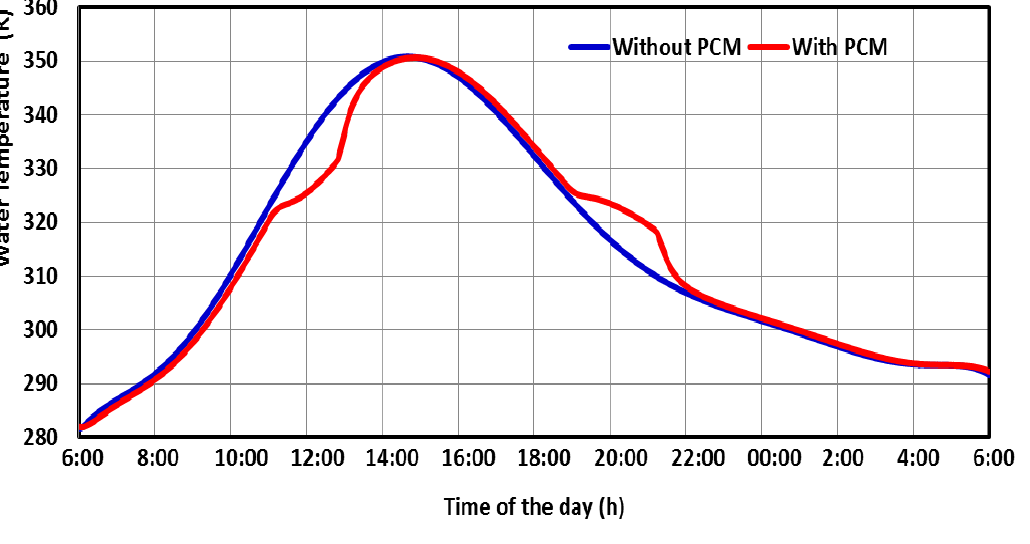
Figure 7. Time evolution of average water temperature for the cases with PCM and without PCM during a complete cycle (charging/discharging).